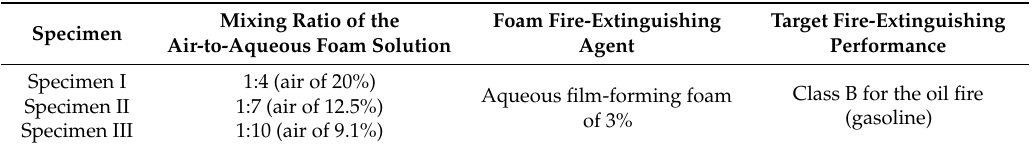
Table 1. Experimental parameters of the